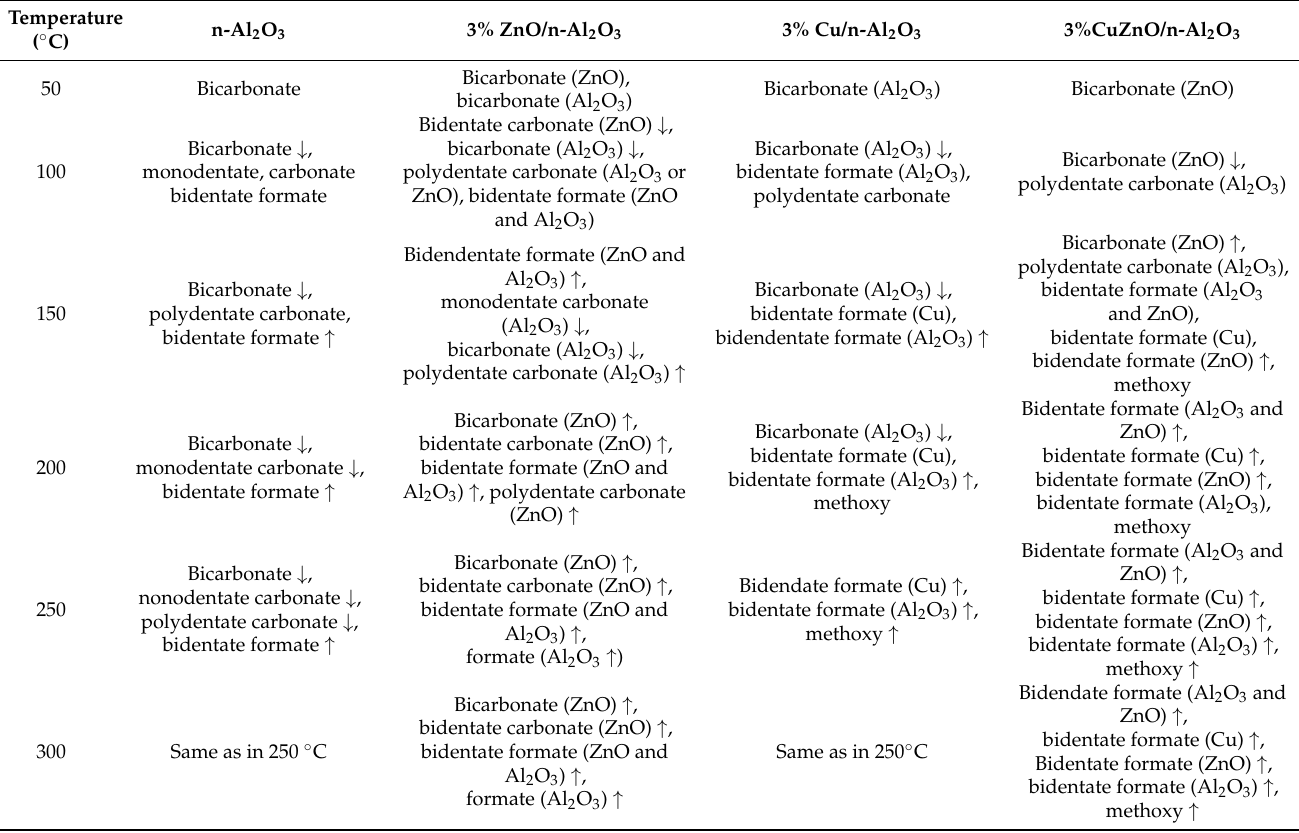
Table 2. Formation of the key intermediates and their peak intensity changes with temperature and catalyst composition